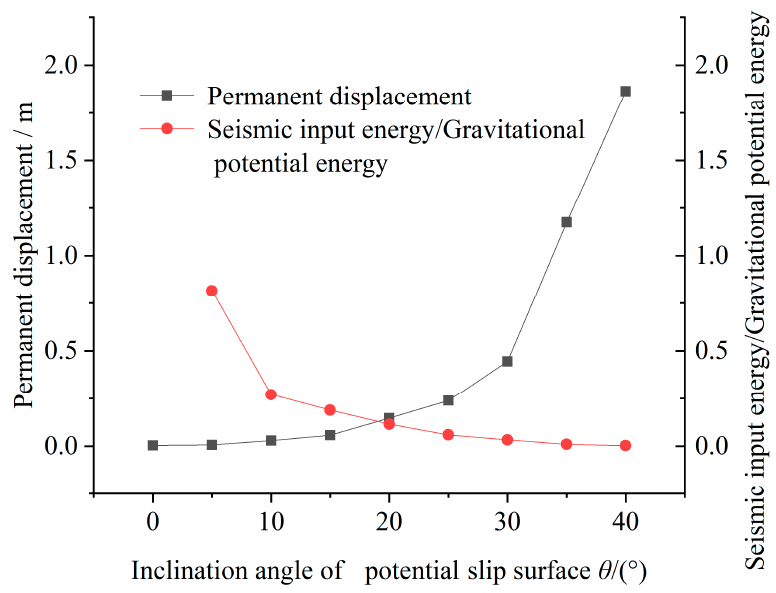
Figure 14. The variation curve on the ratio of seismic input energy to gravitational potential energy and the permanent displacement with inclination angle of potential slip surface.